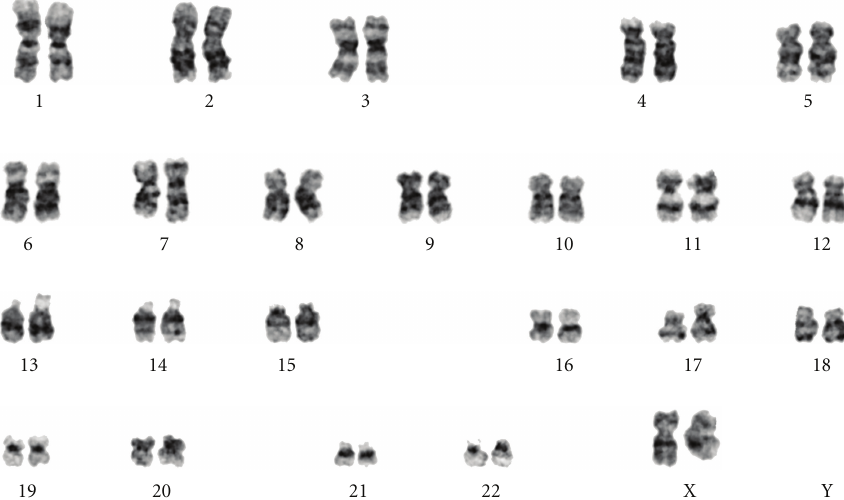
Figure 8: Representative conventional cytogenetics studies from the patient showing 46,XX,+1,der(1;7)(q10;p10). Image courtesy of A/Pro- fessor L Campbell, The Victorian Cancer Cytogenetics Service, St Vincents Hospital